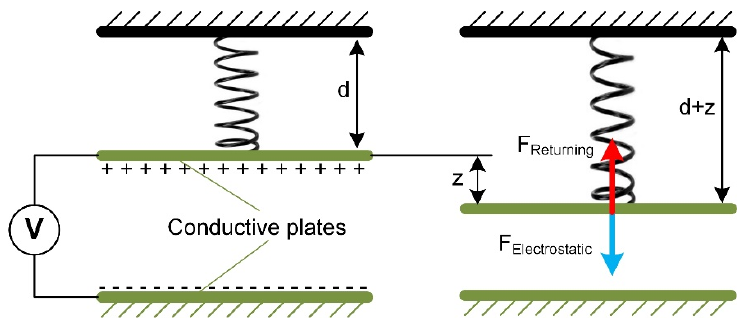
Figure 7. Operating principle of parallel-plate drive, d—initial gap among electrodes, z—displacement of the movable plate. Adapted from [1].